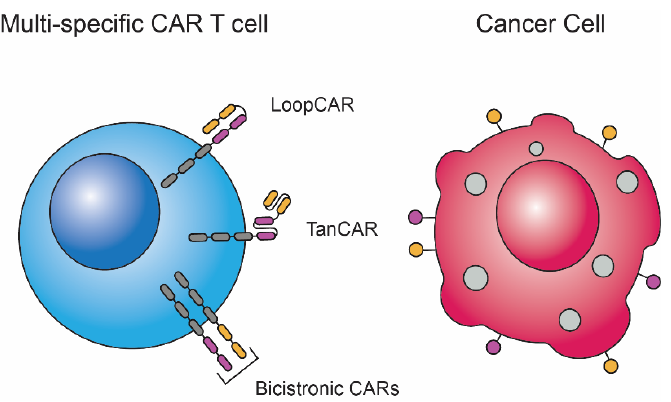
Figure 2. Multi-specific CAR T cell designs. Currently, there are at least three approaches to designing multi-specific CAR T cells that recognize more than one antigen. The most basic design for engineering multi-specific CAR T cells is transducing two (bicistronic) or more CAR constructs into the same cell, which allows multiple antigens to be targeted. Tandem CARs (TanCAR) are CAR constructs with more than one scFv binding domain joined in tandem, allowing multi-specificity. Tandem CAR constructs containing a loop structure (LoopCAR) are also a recent design, which in some cases may be more efficient at bivalent binding compared to TanCARs, as described by Qin et al [61].